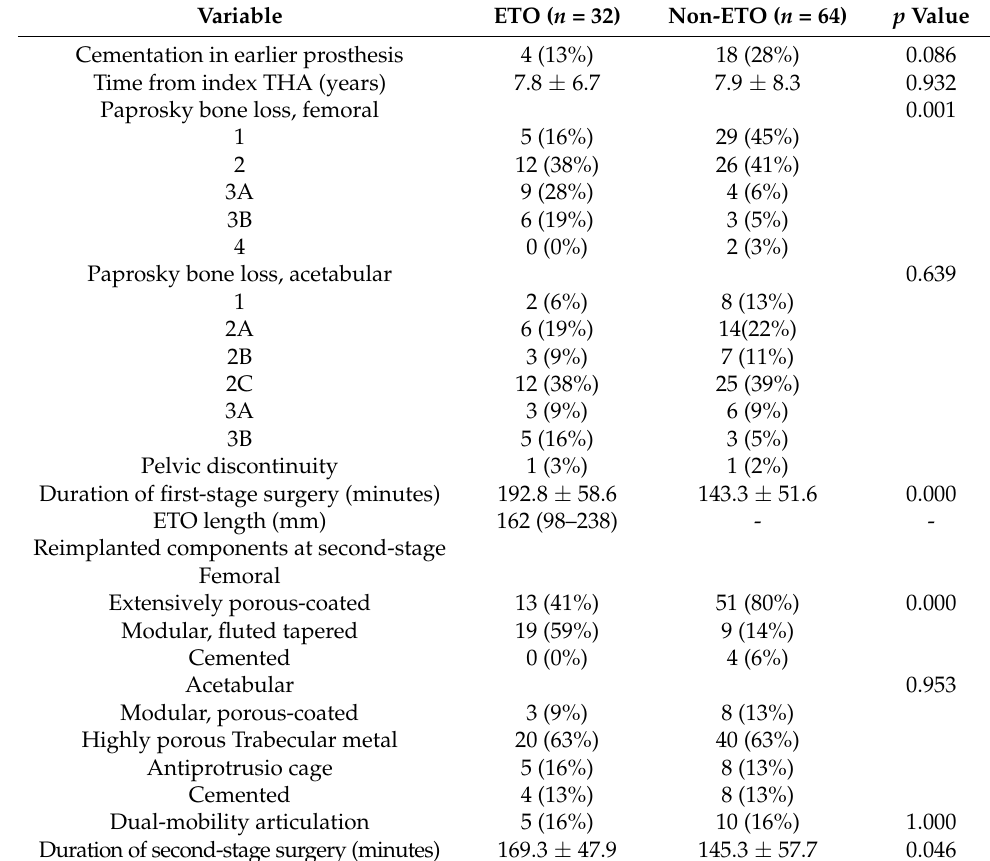
Table 1. Comparison of operative characteristics between ETO and non-ETO group.